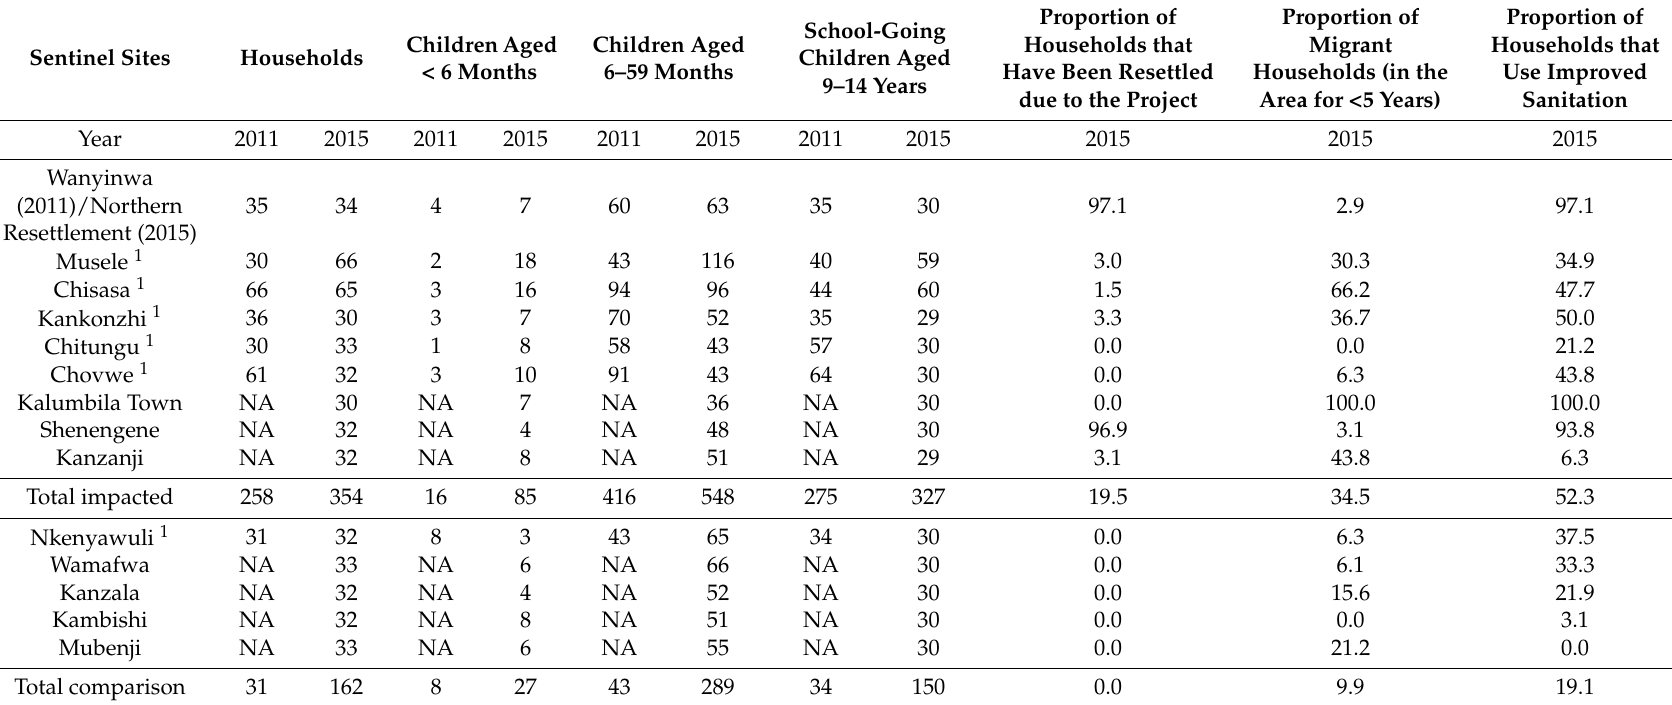
Table 2. Study populations, Trident project, 2011 and 2015,